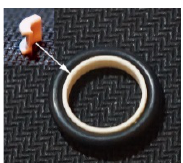
Figure 1. Schematic diagram of piston rod seal structure of Stirling engine.